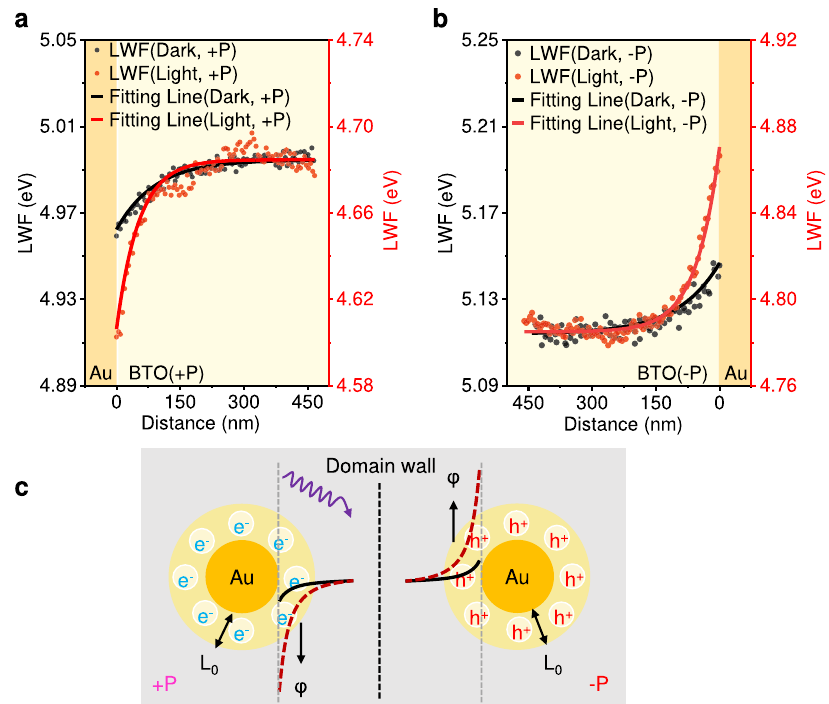
Fig. 2 Quantitative analysis of thermalization length at Au/BTO interface. a LWF and fi tting line at the interface of + P Au/BTO in the dark (black) and 355 nm UV light (red). In dark, φ bi = 32.2 mV, L = 90.7 nm. In light, φ bi = 78.5 mV, L 0 = 52.3 nm. b LWF and fi tting line at the interface of − P Au/BTO in the dark (black) and 355 nm UV light (red). In dark, φ bi = 32.9 mV, L = 98.5 nm. In light, φ bi = 85.6 mV, L 0 = 55.1 nm. c Diagram of charge separation of Au/BTO at + P(left) and − P(right) in the dark (black solid line) and light (red dashed